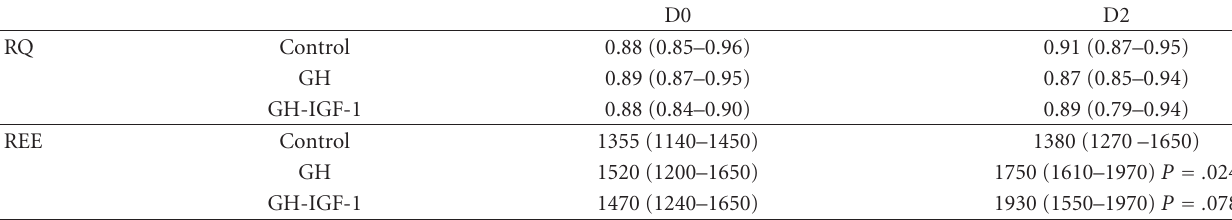
Table 2: Respiratory quotient (RQ) and resting energy expenditure (REE) preoperatively and on the 2nd postoperative day. P < .10 are given as numbers indicating changes within the groups. Values are given as medians and quartiles.